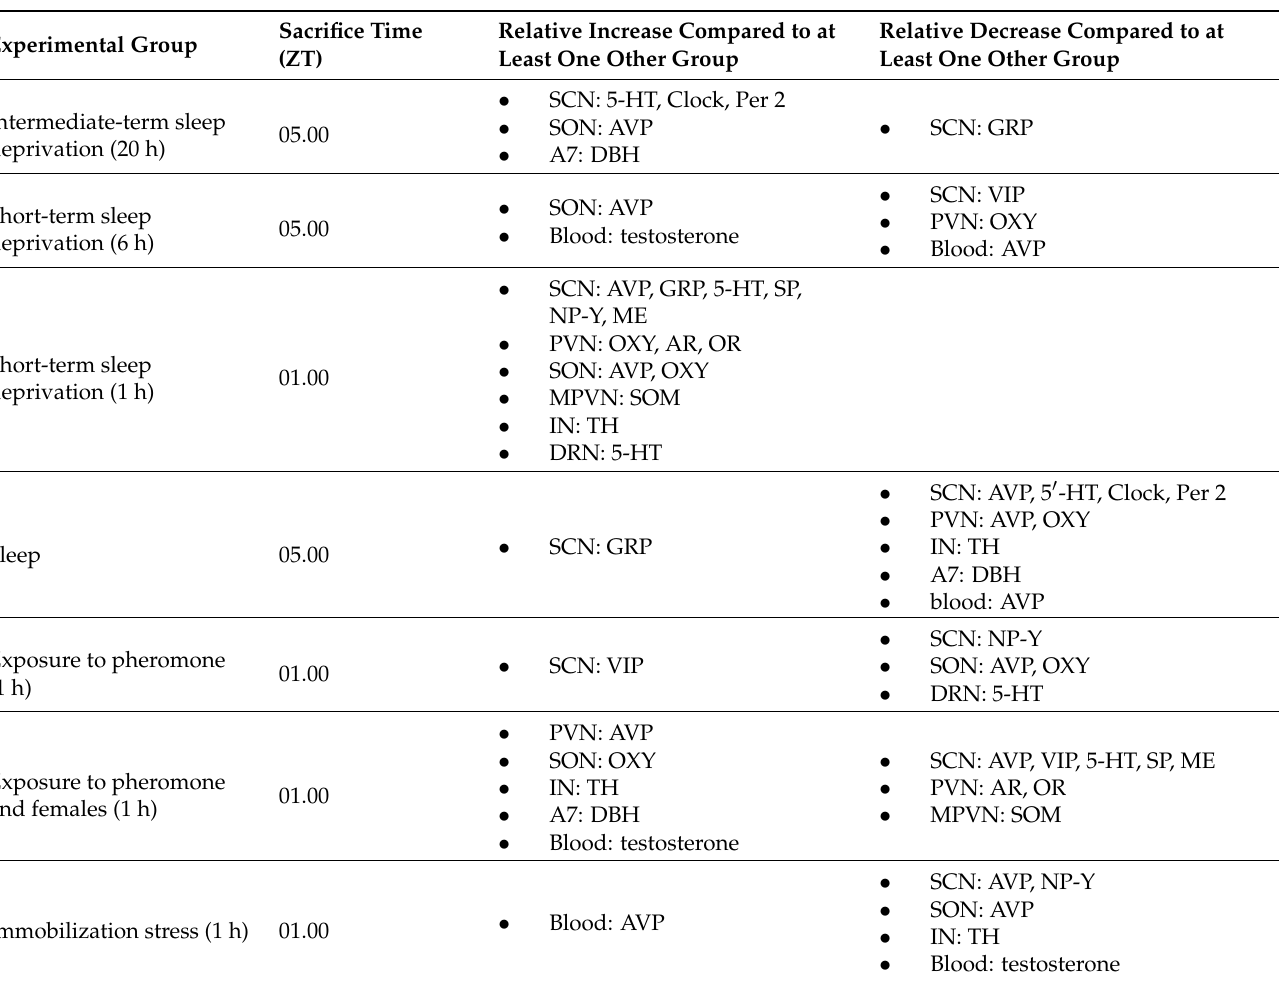
Table 3. Neuromessengers with relative increase or decrease compared to at least one other experimental group for different entities. 5-HT = serotonin (5-hydroxy-tryptophan), AR = androgen receptor, AVP = arginine-vasopressin, DBH = dopamine beta-hydroxylase (the guiding enzyme of norepinephrine synthesis), GRP = gastrin-releasing peptide, ME = met-enkephalin, NP-Y = neuropeptide Y, OR = estrogen receptor, OXY = oxytocin, PER = Period, SOM = somatostatin, SP = substance P, TH = tyrosine hydroxylase (the guiding enzyme of dopamine synthesis), VIP = vasoactive intestinal polypeptide. A7 = A7 neuron population of the brain stem, DRN = dorsal raphe nucleus, IN = infundibular nucleus, MPVN = medial periventricular nucleus, PVN = paraventricular nucleus, SCN = suprachiasmatic nucleus, SON = supraoptic nucleus. ZT = zeitgeber time. Experimental